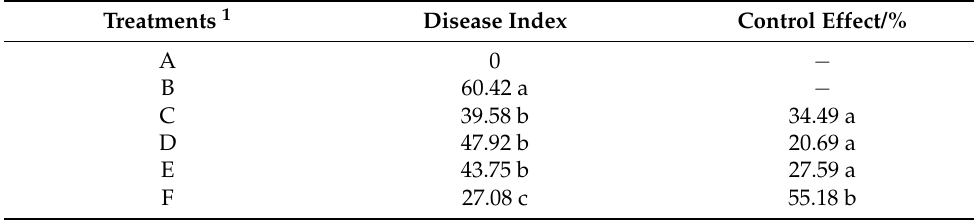
Table 3. Control effects of B5 and B6 on cabbage Fusarium wilt.